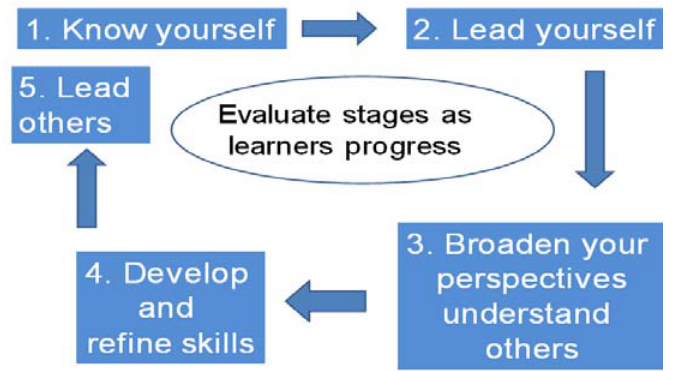
Fig. 3. Model of self-leadership development